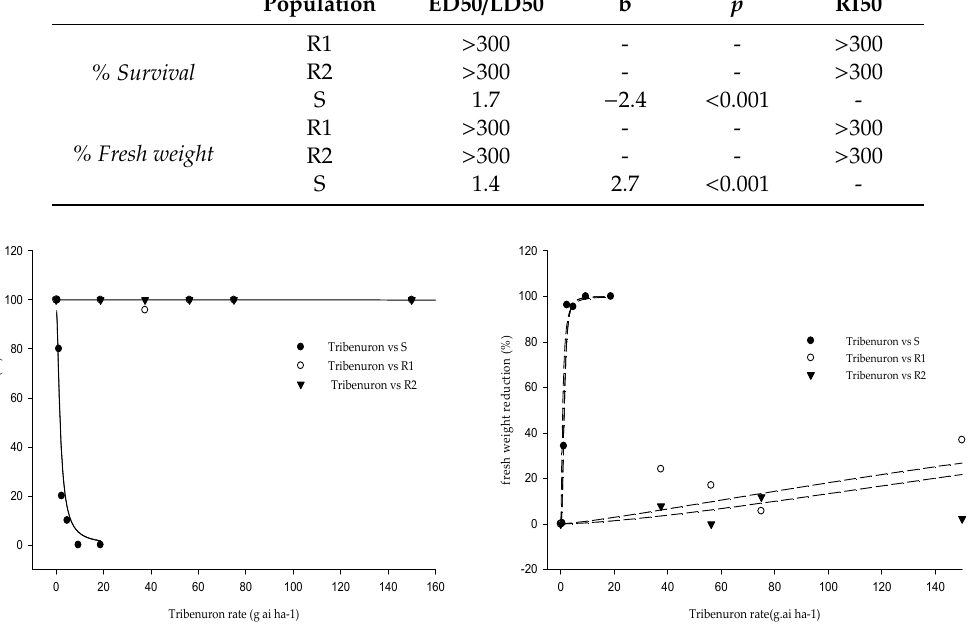
Figure 4. Effects of tribenuron-methyl applied at increasing rates on the plant survivals (%) and shoot fresh weights of sensitive (S) and resistant (R1 and R2) G. coronaria populations 21 days after treatment.